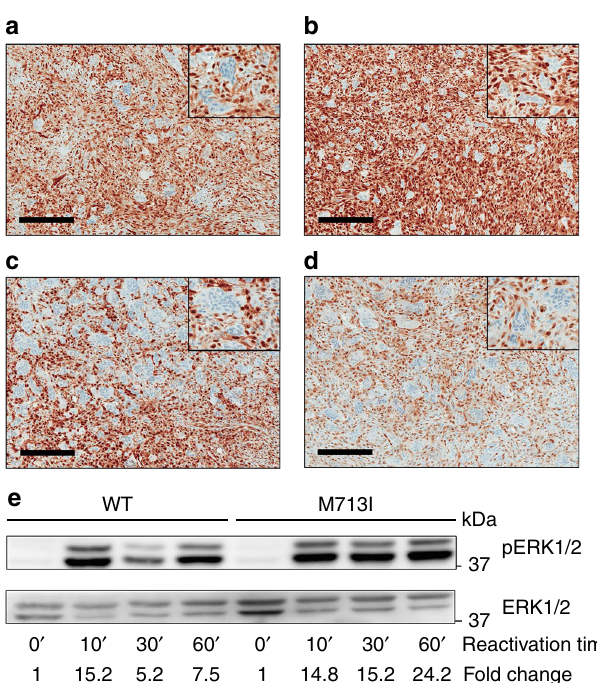
Fig. 3 MAPK pathway activation in GCLJ. Immunohistochemical (IHC) staining for phospho-ERK1/2 shows strong positive staining in mononucleated cells in GCLJ lesions. Representative images of phospho- ERK1/2 staining in TRPV4 p.M713V ( a ), KRAS p.G12D ( b ), and FGFR1 p. C831R ( c ) mutant and in WT ( d ) GCLJ cases. e Immunoblot showing sustained phospho-ERK1/2 (pERK1/2) activation in TRPV4 M713I HEK293 mutant cells compared to WT. A representative experiment of three independent assays is provided. Scale bar represents 200 μ